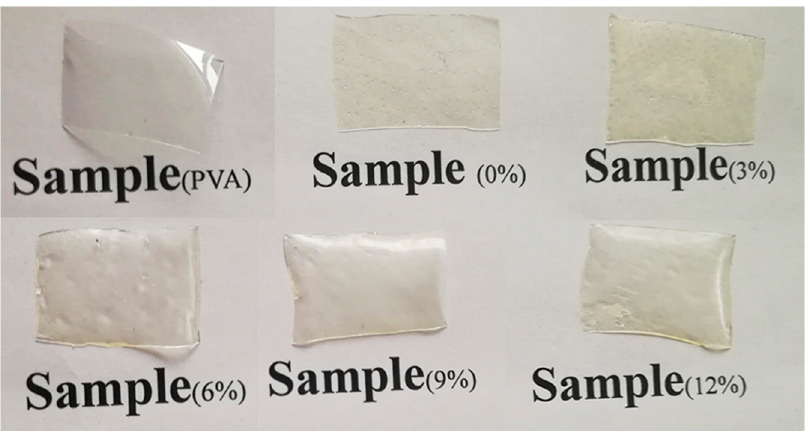
Figure 3. Photograph of PVA and different content KS composite films.